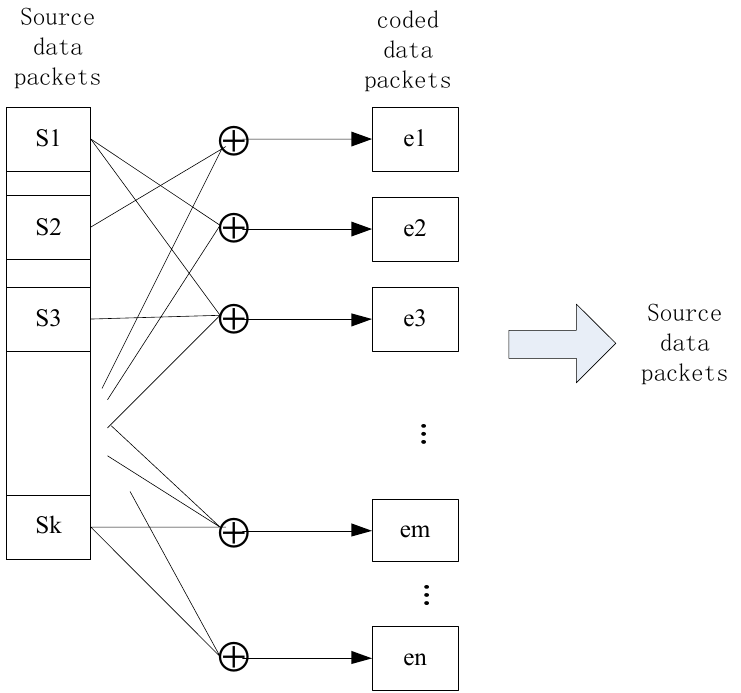
Figure 4. Distributed storage system based on LT